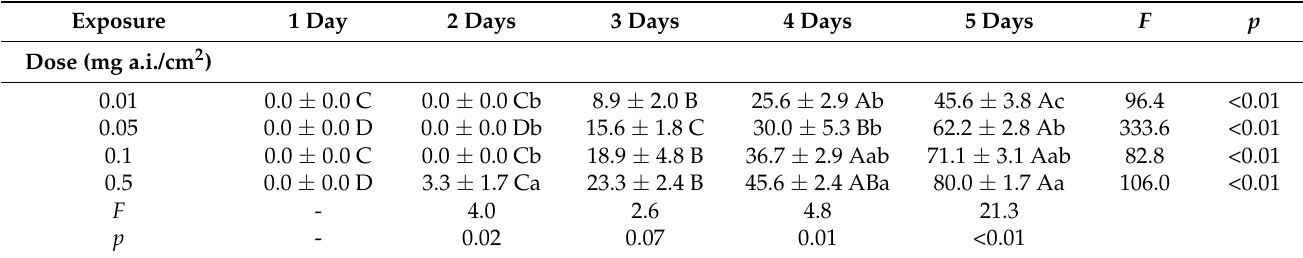
Table 4. Mean immediate mortality (% ± SE) of Sitophilus oryzae adults exposed on concrete treated with chlorantraniliprole at four doses (0.01, 0.05, 0.1, and 0.5 mg a.i./cm 2 ), for 1, 2, 3, 4, and 5 days. Within each row, means followed by the same uppercase letter are not significantly different (in all cases DF = 4, 44, Tukey–Kramer HSD test at p = 0.05). Within each column, means that are followed by the same lower-case letter are not significantly different (in all cases DF = 3, 35, Tukey–Kramer HSD test at p = 0.05). Where no letters exist, no significant differences were recorded. Where dashes exist, no analysis was